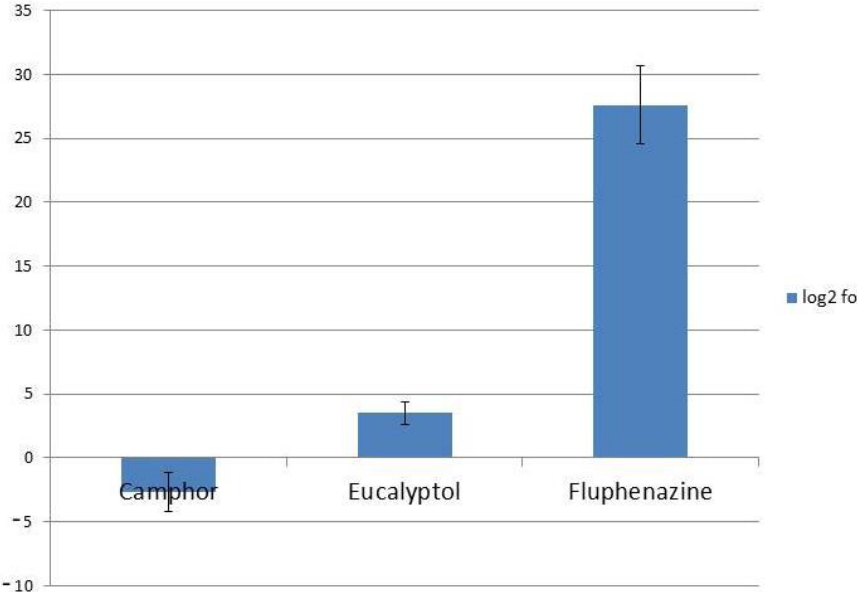
Figure 6. Expression levels of CDR2 after treatment with MIC of camphor and eucalyptol; fluphenazine was used as a positive control for CDR2 expression. Values are expressed as the log2 FC of RQ values and presented as an average of two biological replicates.